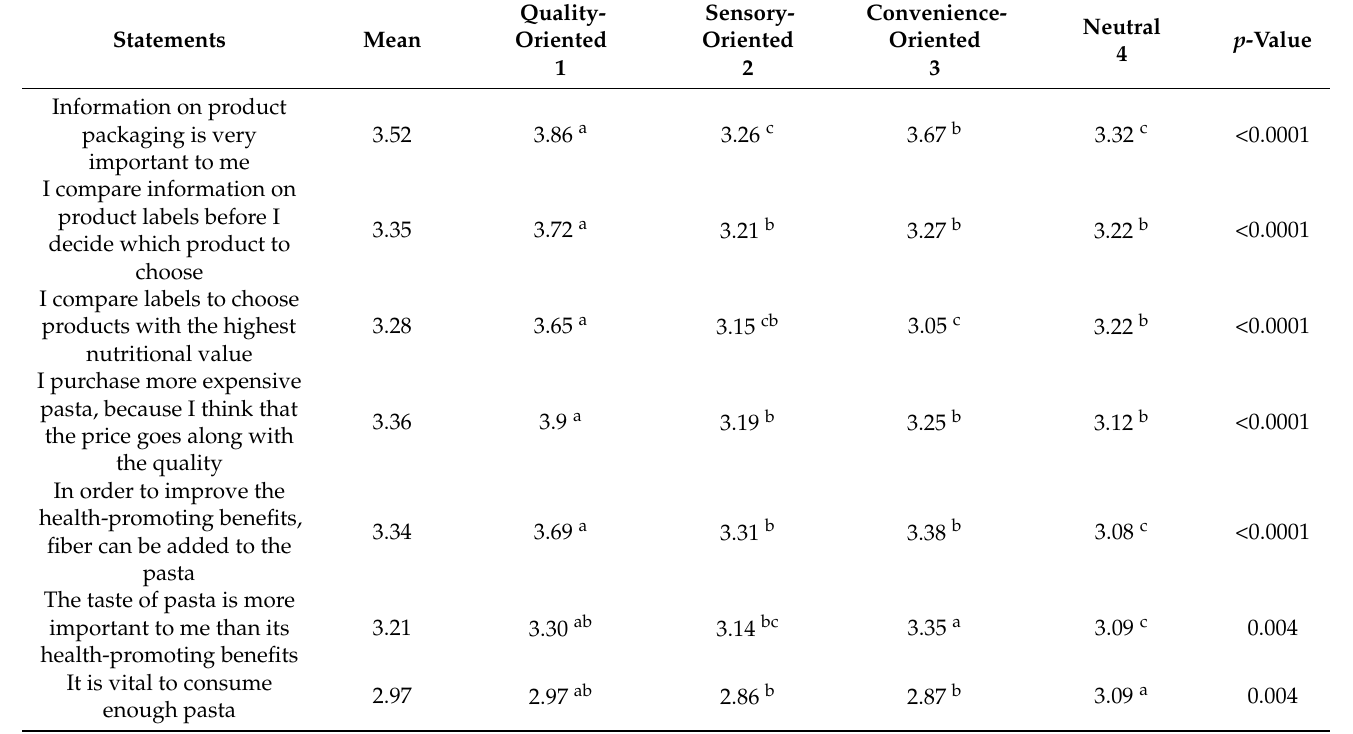
Table 5. Profile of segments according to statements on pasta and information on food